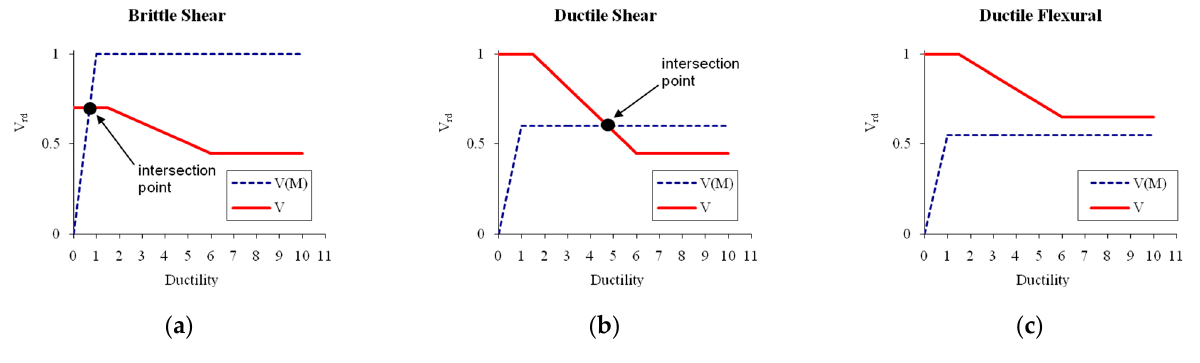
Figure 3. Case study: ( a ) plan view; ( b ) elevation and section view ( c ).